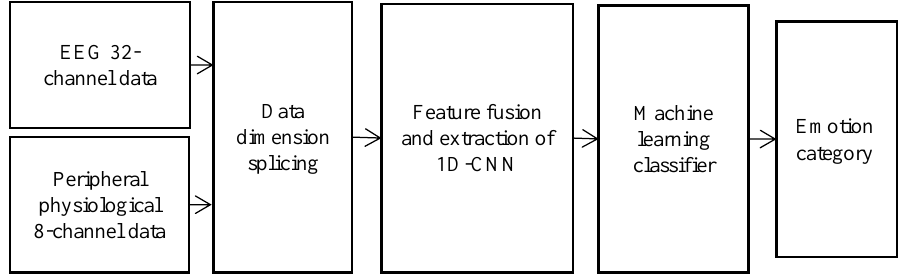
Fig. 1. Emotion recognition model based on multi-source physiological signal with data